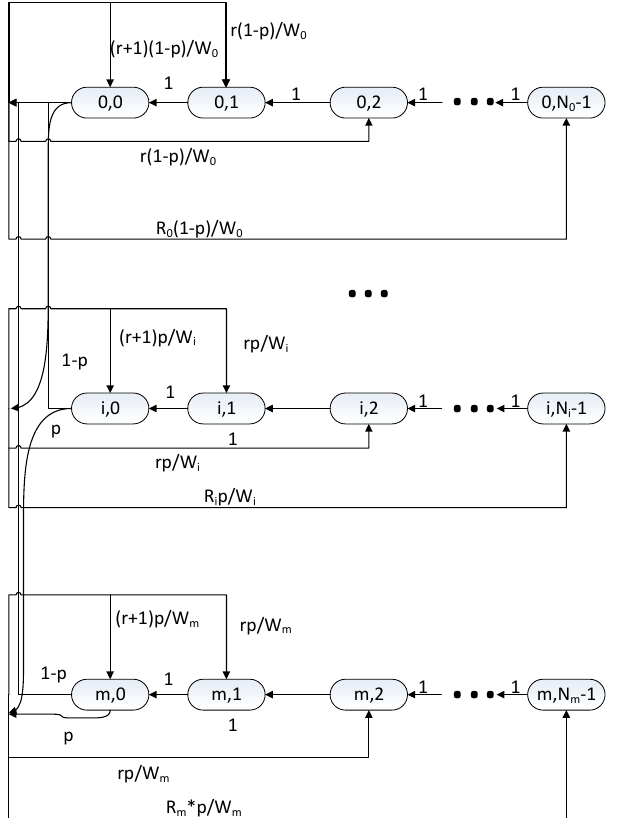
Figure 9. Simplified Markov chain model of UORA channel access.